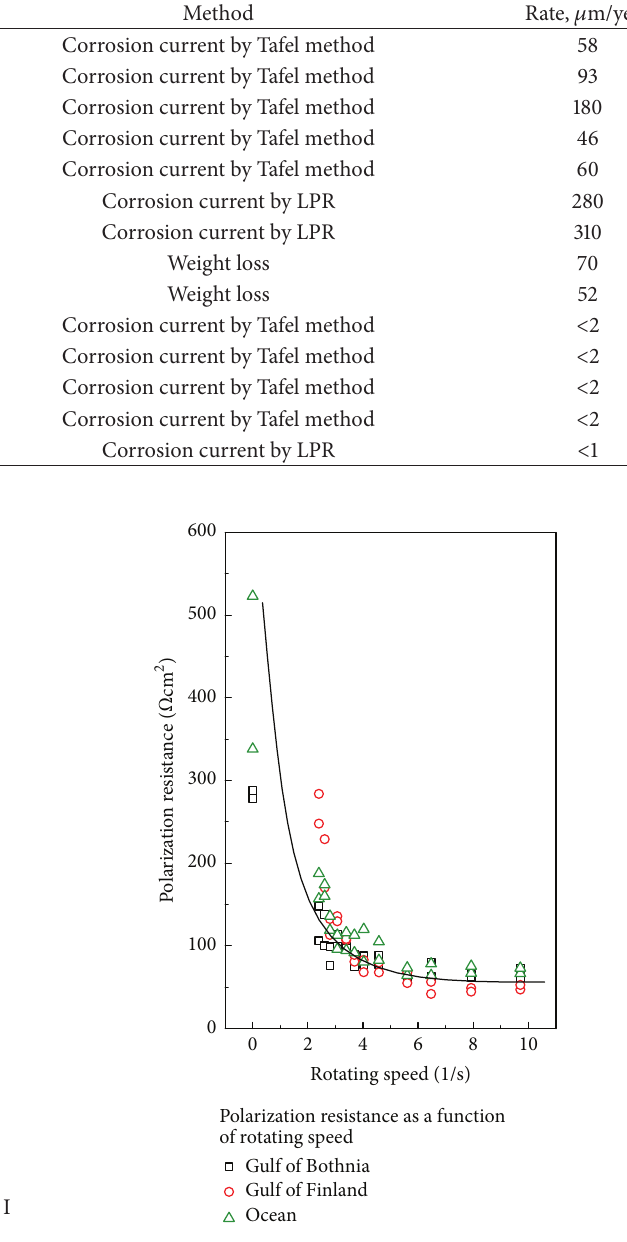
Figure 7: Polarization resistance as a function of rotating speed in three Type I synthetic seawater samples of different